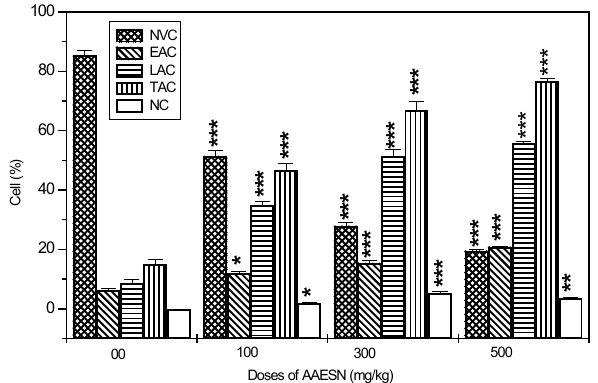
Fig. 3. Shows AAESN induced cytotoxicity observed on WRBMCs under a fluorescent microscope. NVC: normal viable cells; EAC: early apoptotic cells; LAC: late apoptotic cells, TAC: total apoptotic cells. NC: necrotic cells. Experiments were done in three sets and data were represented as Mean±SEM. * Significant at p<0.05, ** at p<0.01 and *** at p<0.001 as compared to the control by 2x2 contin- gency χ 2 -test